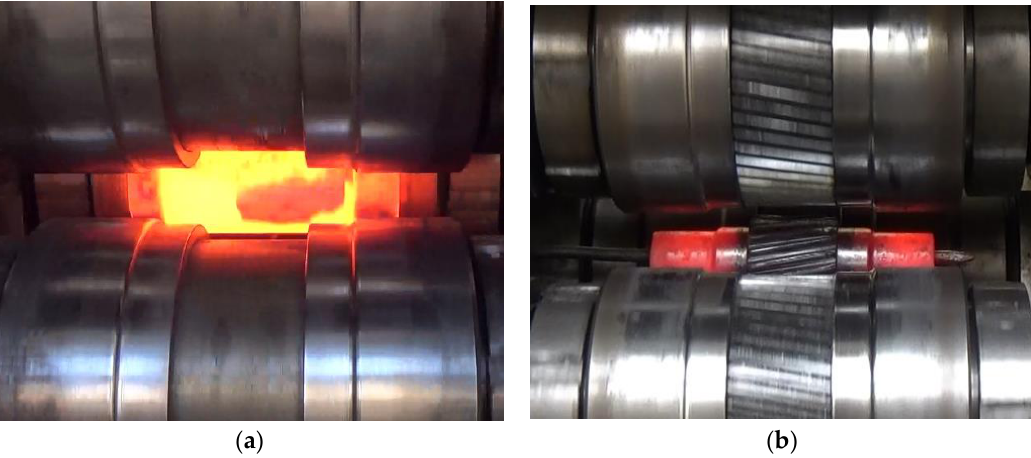
Figure 10. Rotary compression of a hollow stepped gear shaft: ( a ) rotary compression of a hollow shaft with smooth steps, ( b ) formation of a gear on the central step of the shaft.